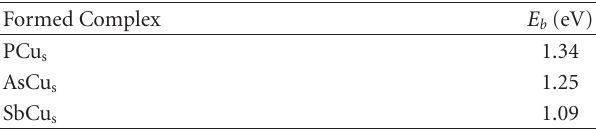
Table 2: Calculated binding energy E b of P V c , As V c , Sb V c to Cu. Formed